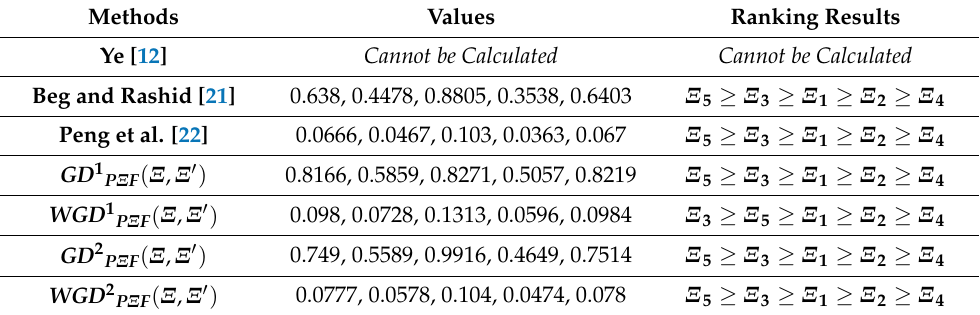
Table 6. Contained comparative